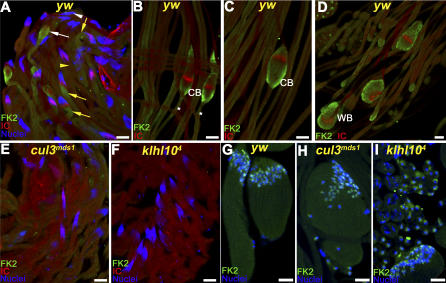
The Cul3-Roc1b-Klhl10 Complex Promotes Protein Ubiquitination during Spermatid IndividualizationTestes were stained with the anti–multi-ubiquitin monoclonal antibody (FK2) that detects ubiquitinated proteins (green), phalloidin, which marks the individualization complex (IC, red), and DAPI to visualize the nuclei (blue).(A) Before the formation of an IC, very low levels of ubiquitinated proteins are detected (yellow arrowhead). Once a mature IC is assembled in the vicinity of the nuclei, a steep gradient of ubiquitinated protein staining is detected from the very bottom of the nuclei to the tip of the spermatids' tails (yellow arrows). After the caudal translocation of the IC, ubiquitinated proteins are no longer detectable in the post-individualized portion of the spermatids (the region between the nuclei, indicated by a white arrowhead, and an early CB, indicated by a white arrow).(B and C) When the bulk cytoplasm of the spermatids accumulates in a cystic bulge (CB), ubiquitinated proteins are prominent within the CB and the pre-individualized region (white asterisks).(D) Once all the cytoplasm is stripped away, ubiquitinated proteins are detectable only in the waste bag (WB).(E and F) Elongated spermatids from either cul3mds1 or klhl104 mutants, respectively, did not stain for ubiquitinated proteins.(G) Protein ubiquitination is detected in nuclei of early elongating spermatids.(H and I) The pattern of protein ubiquitination at earlier stages of spermatid maturation is not affected in cul3mds1 and klhl104 mutants.Scale bars, 100 μm.